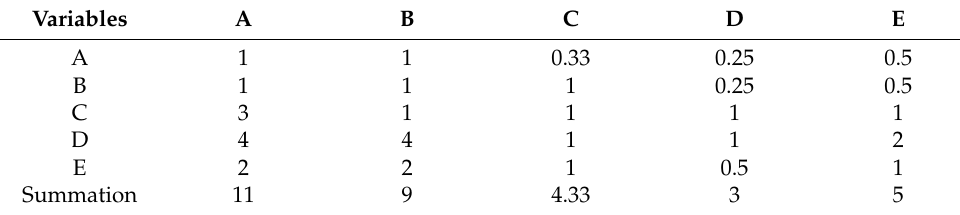
Table 5. The subjective weighting of